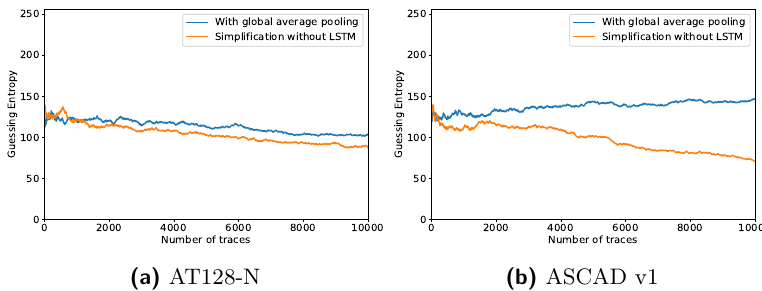
Figure 15: Guessing entropy of CNNs with global average pooling and the simplification of our